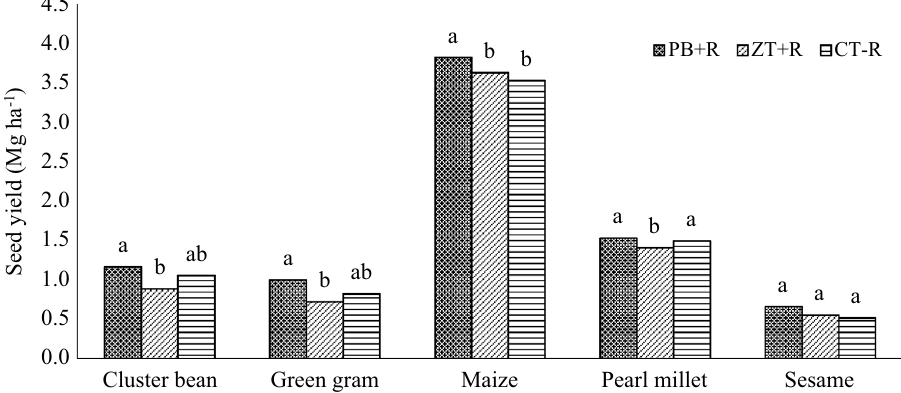
Figure 1. Yield of rainy season crops in Indian mustard-based cropping systems under different CA practices (mean of 3 years).